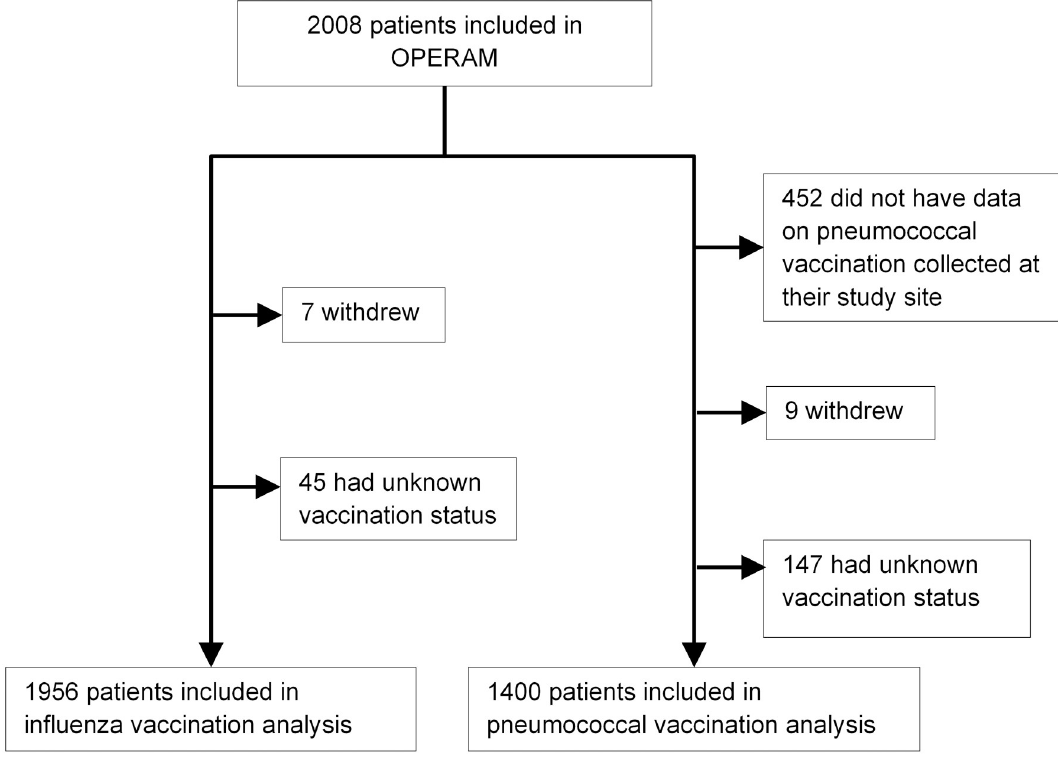
Fig 1. Overview of the study